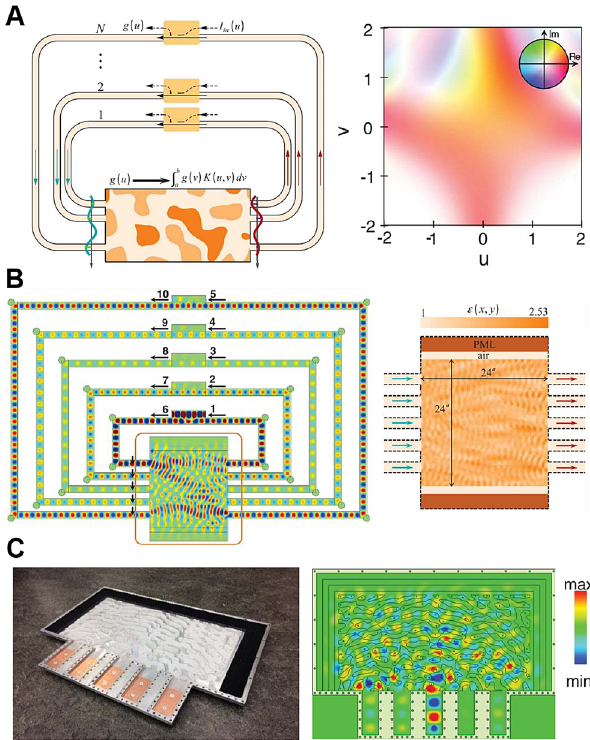
Figure17: Solvingintegralequationwithwaves ininverse-designed metastructures [74]. (A)Leftpanel:theschematicofaclosed-loopnetworkconsistingofa properlydesignedkerneloperator(i.e.,themetamaterialblock)that performs the desired integral operation on the input wave, N feedback waveguides for realization of the recursive paths, and directional couplers to feed/probe the input/output wave. Right panel: complex density plot of the fi rst complex-valued kernel K 1 ( u , v )inthe( u , v )planeinEquation(2)inthestudybyEstakhrietal.[74]. (B) Left panel: time snapshot of the simulated out-of-plane component of the electric fi eld distribution in the closed-loop network when excited at port 1, with the other four ports unexcited. Right panel: inhomogeneous metamaterial kernel designed for performingintegraloperationenclosedwithabsorbinglayersontop and bottom and perfect electric conducting walls on all other sides. (C) Left panel: an image of the fabricated metastructures in which white, gray, and black areas show polystyrene, air, and absorbing materials,respectively.Theouterelectricconductingwallsaremade of aluminum. Right panel: time snapshot of the simulated out-of- plane component of the electric fi eld distribution in the closed-loop network when excited at port